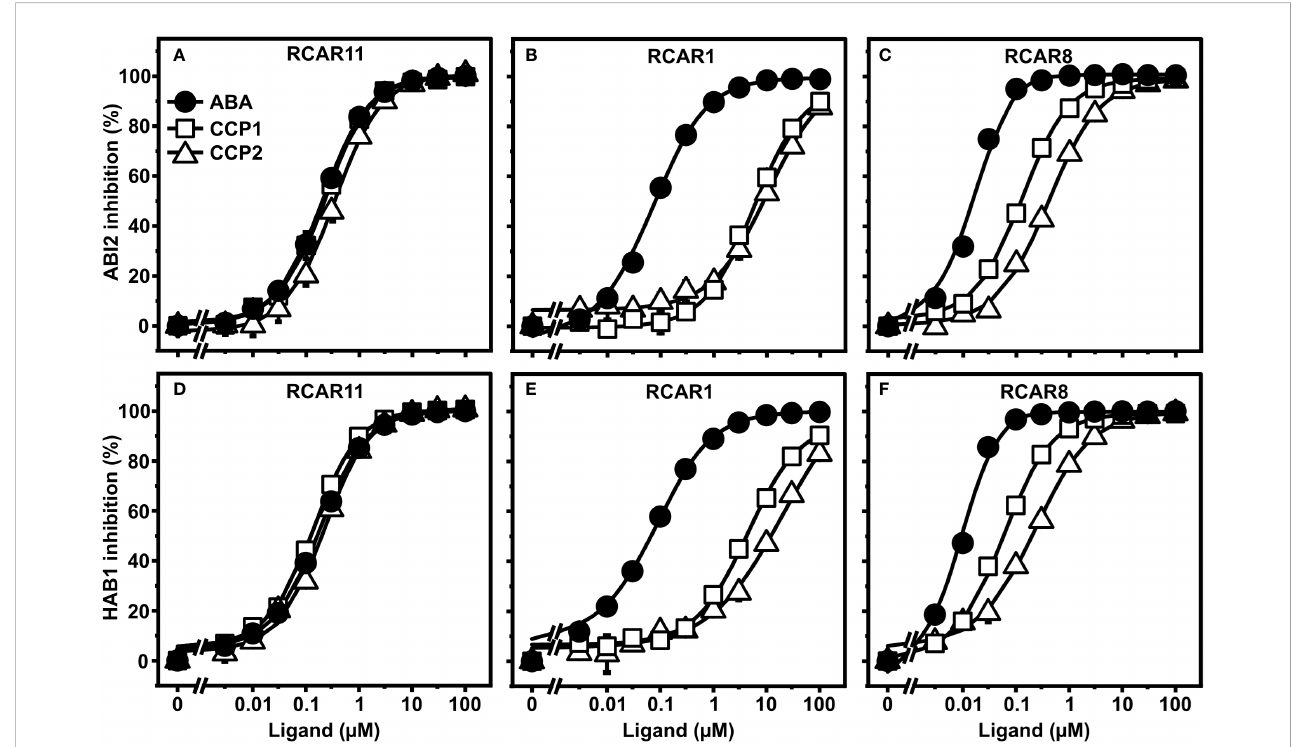
FIGURE 3 CCP1- and CCP2-mediated regulation of ABA receptor complexes. (A – C) ABI2 and (D – F) HAB1 were analyzed in combination with RCAR11 (A, D) , RCAR1 (B, E) , and RCAR8 (C, F) for ligand-dependent inhibition of their phosphatase activity. The in vitro analysis was performed by using 100 nM PP2C and a two-fold molar excess of RCAR at different concentrations of ABA ( fi lled circles), CCP1 (open squares), and CCP2 (open triangles). n = 3 replicates, mean ± SD. Statistical signi fi cance is provided in Supplementary Tables 3 –